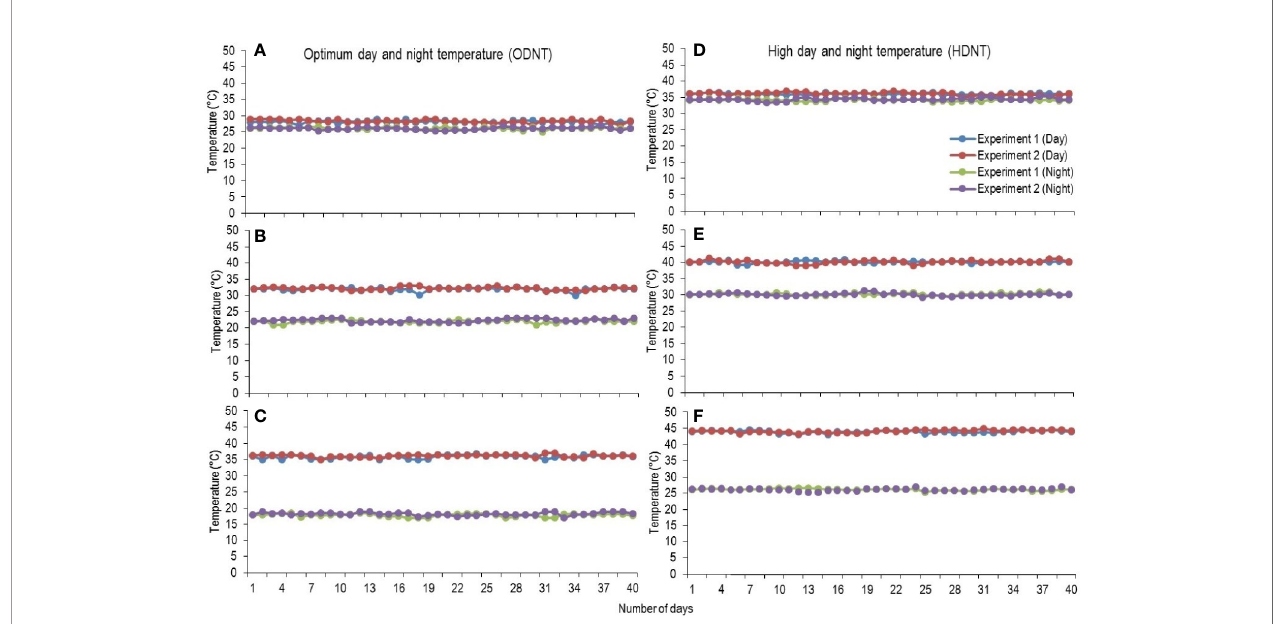
FIGURE 1 | Maximum daytime (from 10:00 h to 14:00 h) and minimum nighttime temperature (from 22:00 h to 02:00 h) of two mean temperatures (27 and 35°C) with three diurnal temperature amplitudes (2 10, and 18°C) exposure lasting 40 days in controlled environment chambers. Mean optimum temperature [optimum mean daytime and nighttime temperature (ODNT)] 27°C: (A) Day/night temperature 28/26°C (diurnal temperature amplitude 2°C), (B) 32/22°C (diurnal temperature amplitude 10°C) and (C) 36/18°C (diurnal temperature amplitude 18°C). Mean high temperature [high mean day/night temperature (HDNT)] 35°C: (D) Day/night temperature 36/34°C (diurnal temperature amplitude 2°C), (E) 40/30°C (diurnal temperature amplitude 10°C) and (F) 44/26°C (diurnal temperature amplitude